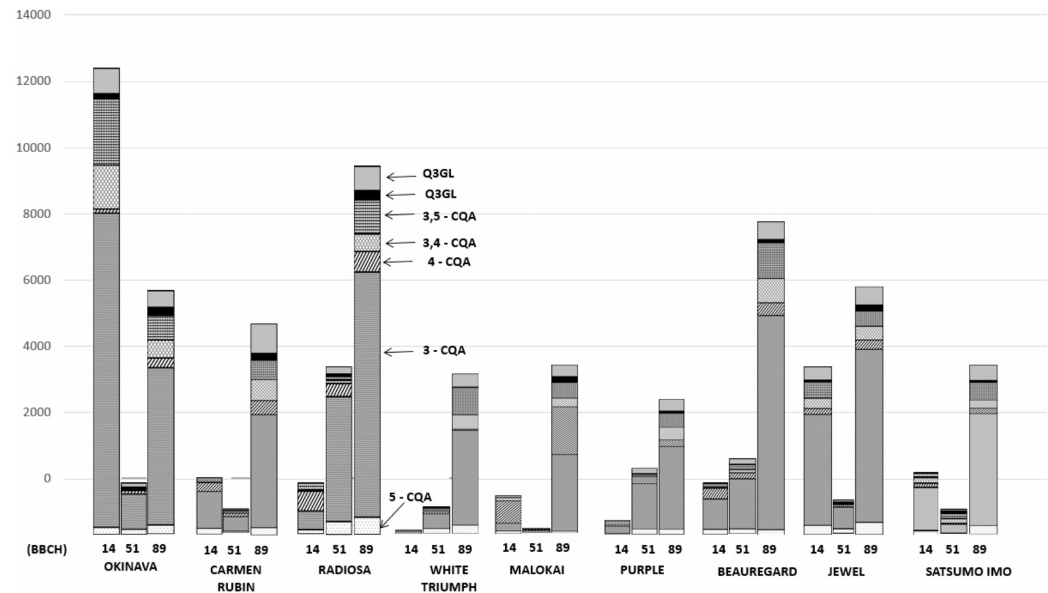
Figure 1. Polyphenol content in sweet potato leaves (mg / 100 g − 1 DM) depending on the development phase according to the BBCH